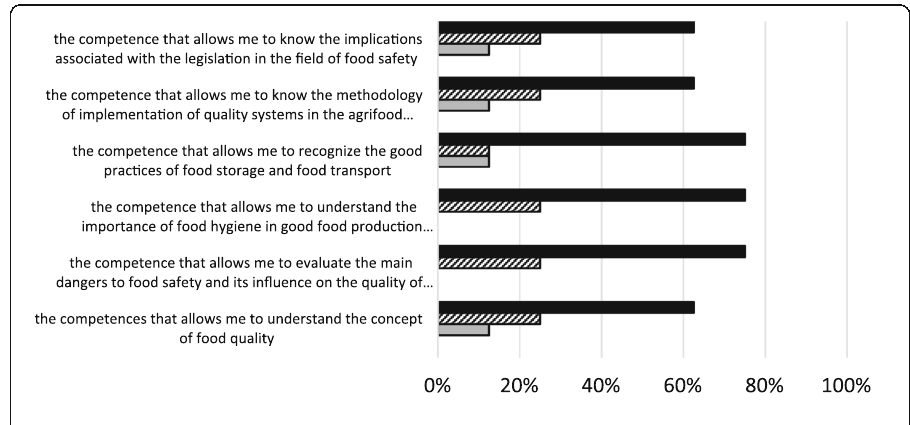
Fig. 4 Students ’ perceptions about acquisition of competences in the